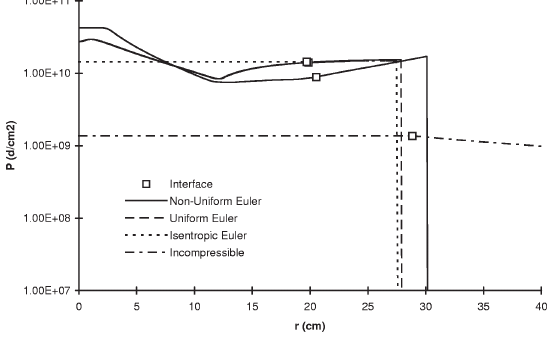
Fig. 4. Comparison of solutions during expansion sub-phase, at t = 2 : 06 (cid:2) 10 (cid:0) 5